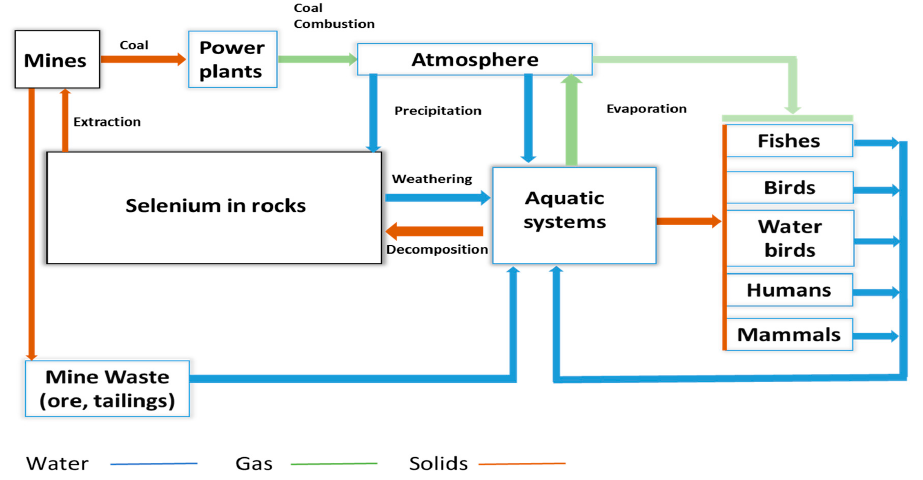
Figure 2. Schematic showing selenium cycling in the environment from mining.